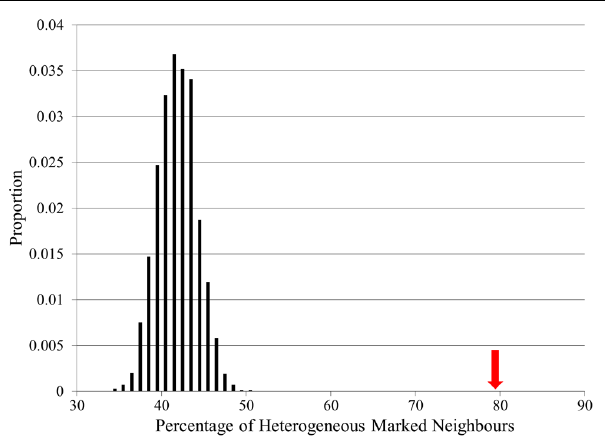
FIGURE 4 | Locus heterogeneity gene interconnectivity within the full CPDB network compared to random simulations. There is a normal distribution of random simulations (black bars), with a mean value of 41.9%. The red arrow indicates the actual percentage connectivity of locus heterogeneity genes (79.7%), showing a significant difference from 10,000 random